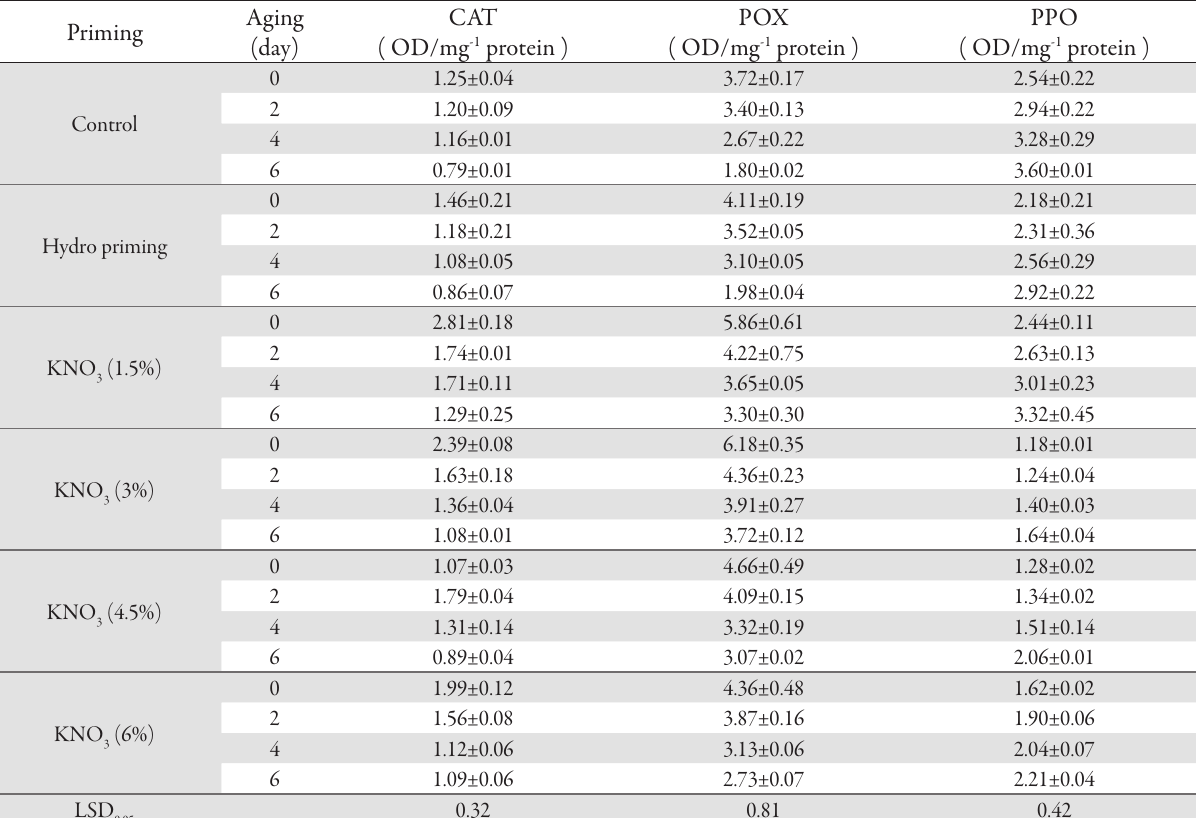
Tab. 3. Amounts of CAT, POA and PPO of milk thistle Hypocotyl subjected to various treatments